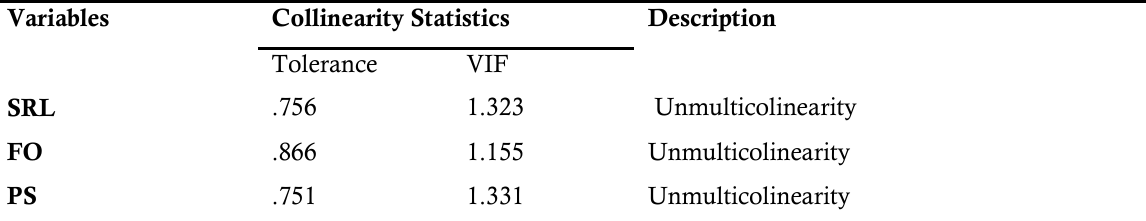
Table 5. The result of multicolinearity